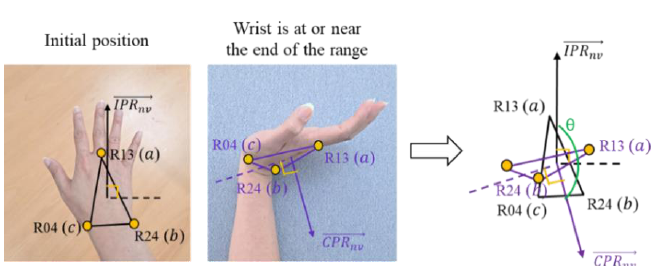
Figure 9. Wrist twist position in the range.